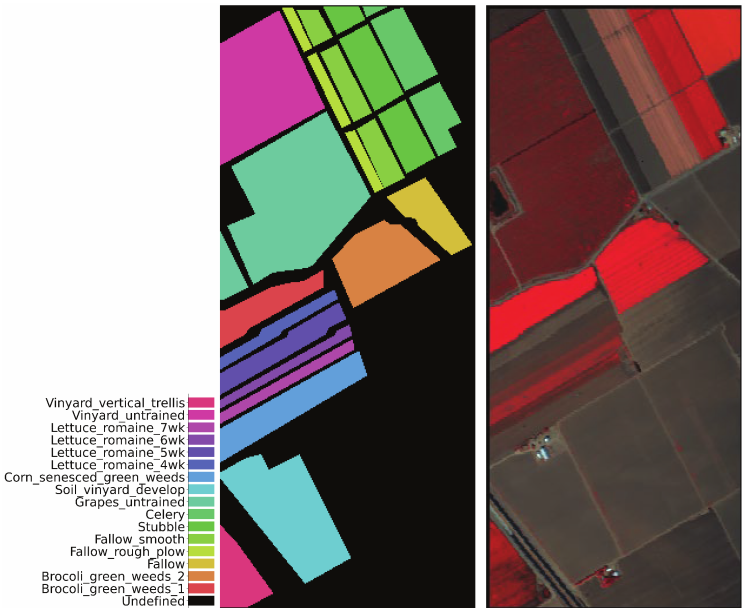
Figure 8. Salinas dataset: Left is the names of classes, Center is ground truth, Right is the RGB